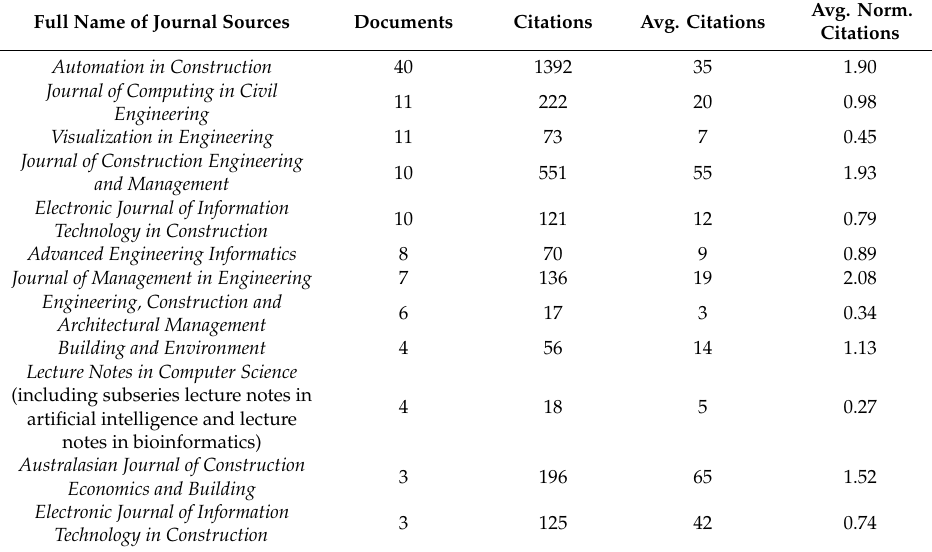
Table 3. Details of published journals.